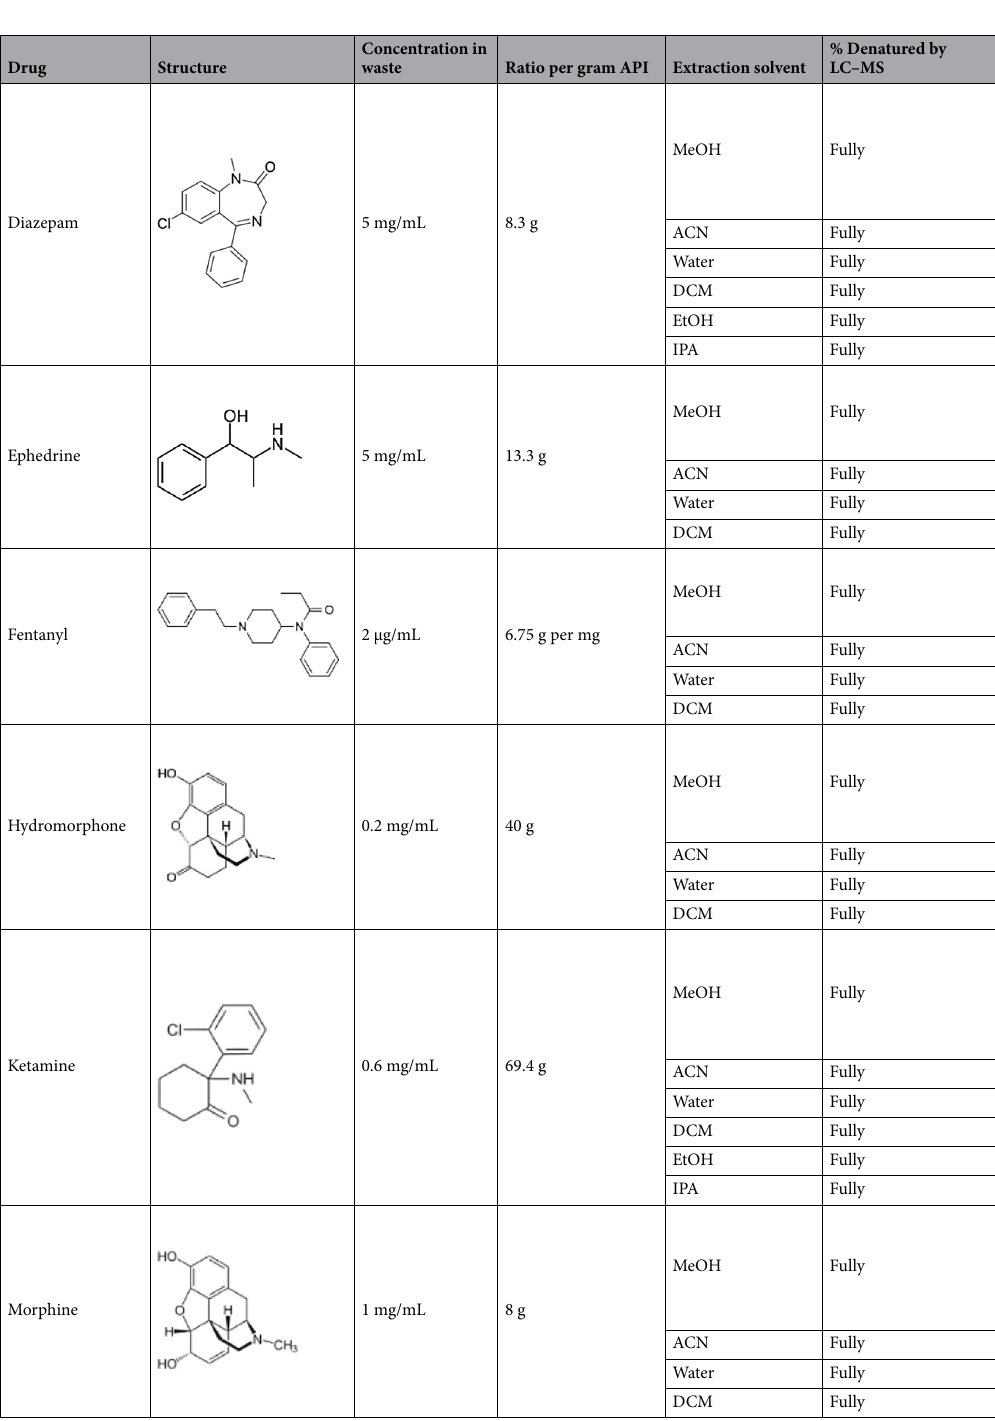
Table 3. Summary of beta test using manufacturing waste stream. The ratio is the grams of SafeMedWaste active ingredients required to denature 1 g of API in the waste stream. MeOH = methanol, ACN = acetonitrile, DCM = dichloromethane, EtOH = ethanol, IPA = isopropyl